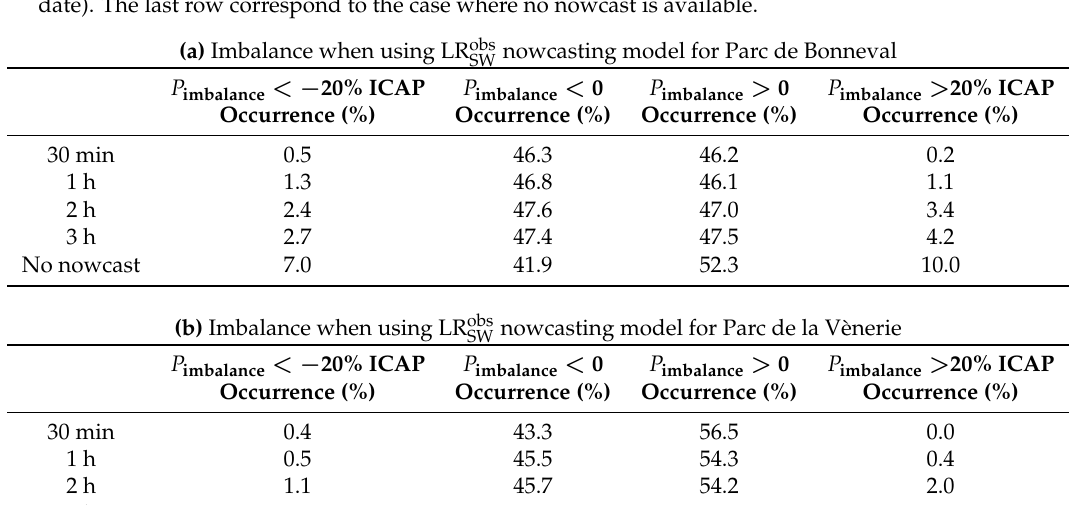
Table 4. Frequency at which P imbalance exceeds different thresholds. Percentages for the large